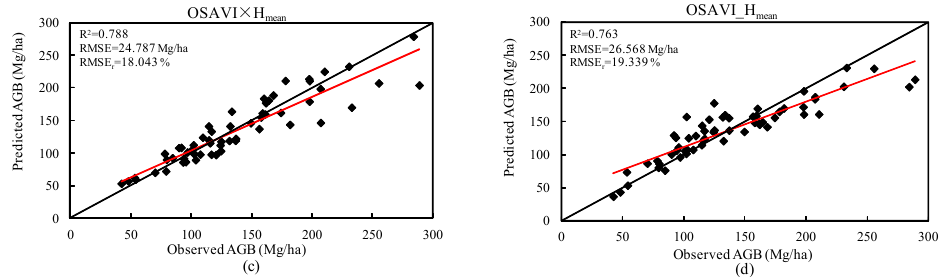
Figure 3. Comparisons between field observations and model predictions by using different data